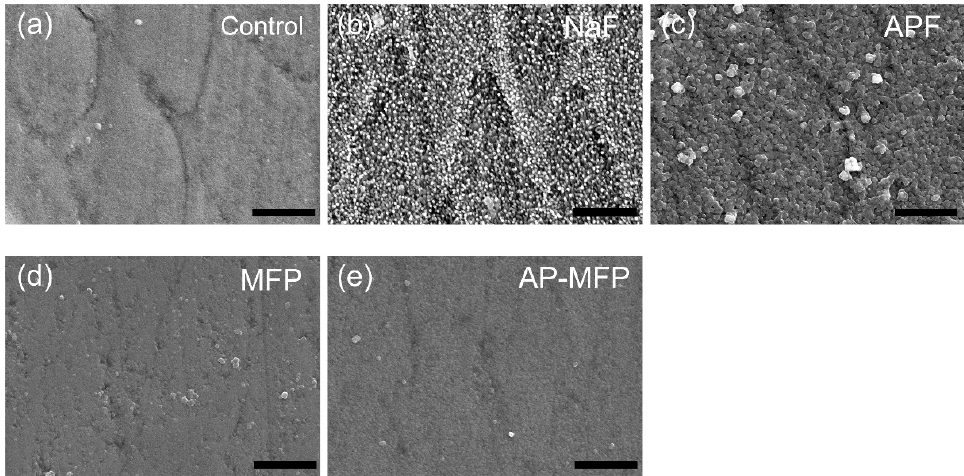
Figure 2. Surface SEM images of the samples from the ( a ) control, ( b ) NaF, ( c ) APF, ( d ) MFP, and ( e ) AP-MFP groups after the acid challenge. Scale bar is 2.5 μ m. All images were recorded at 10,000-fold magnification.